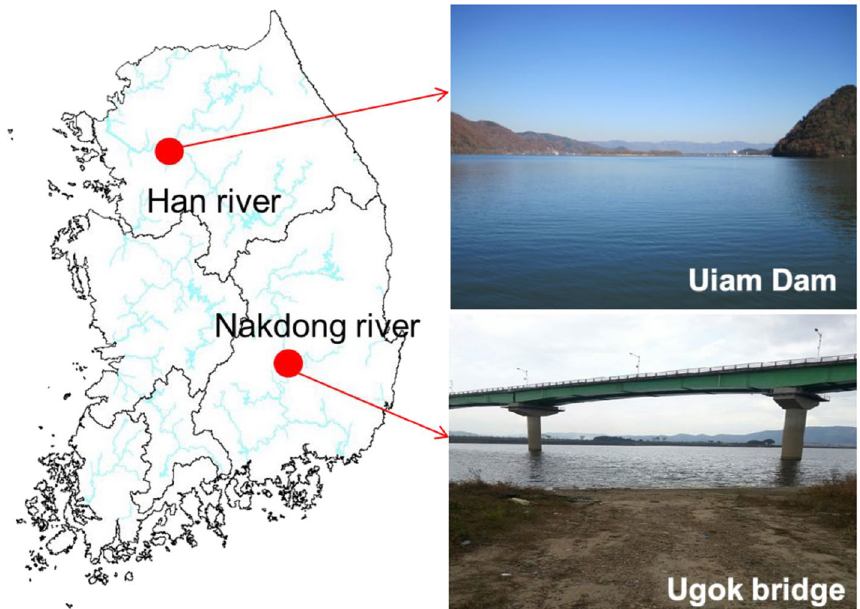
Fig. 1 Study sites (akinetes were sampled at the Uiam Dam and resting cells were sampled at the Ugok bridge)